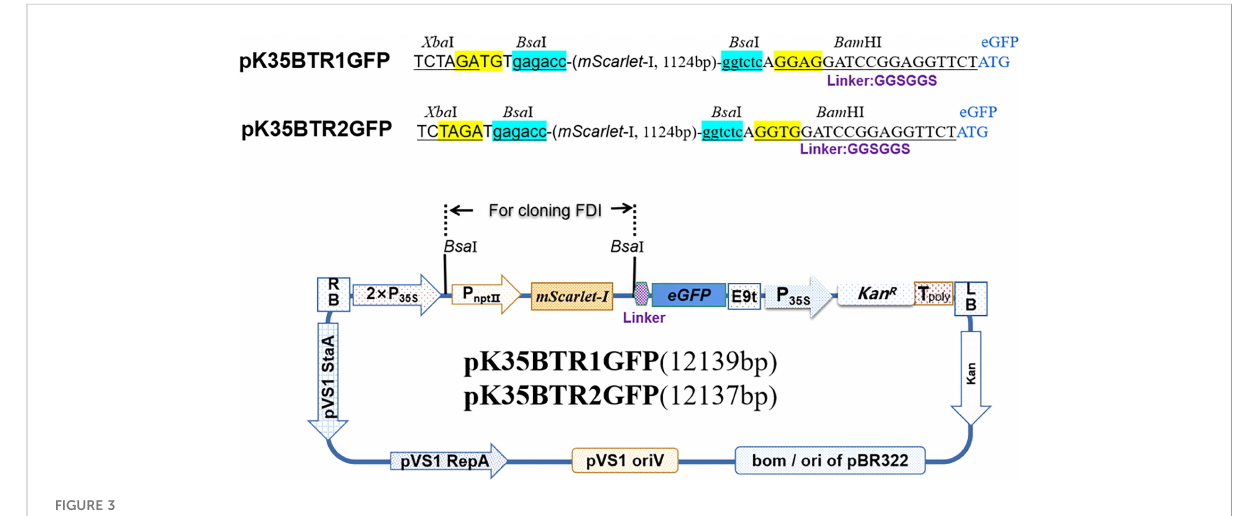
FIGURE 3 Diagram of subcellular localization